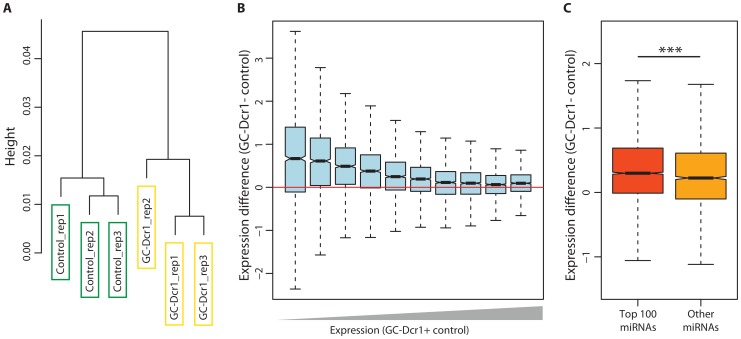
Altered mRNA transcriptome in GC-Dcr1 spermatocytes.(A) Hierarchical clustering of the six sequenced samples. We calculated the distance between each pair of samples as 1 - rho, where rho was the Spearman correlation coefficient for the gene expression levels in the two samples. Clustering was performed using the hclust function in R and Ward's method. (B) Overview of the normalized gene expression data. Genes were grouped into 10 equally sized bins based on their combined expression in GC-Dcr1 and control spermatocytes. Highly expressed genes are shown on the right. Expression change was calculated as the difference between the log2-transformed normalized expression values in GC-Dcr1 and control spermatocytes. (C) Comparison of expression change in genes targeted by highly and lowly expressed miRNAs (see text for details). Expression change was calculated as in (B).